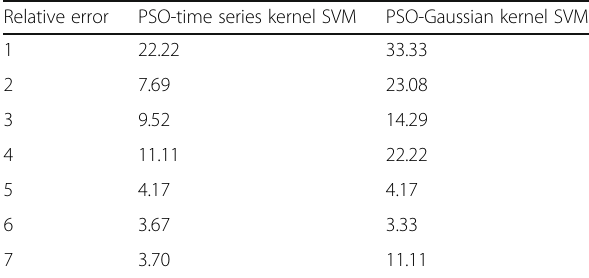
Table 9 Relative error of a certain week in June Relative error PSO-time series kernel SVM